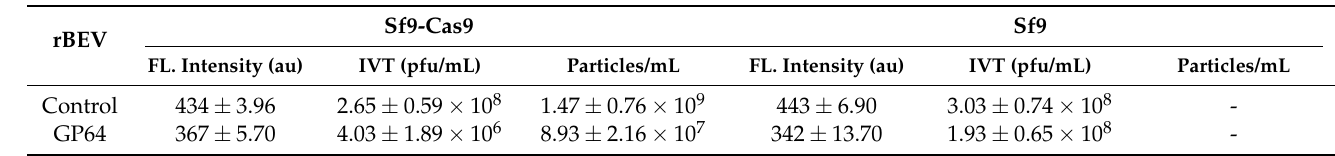
Table 3. Summary of fluorescence intensity and virus quantification data for rBEVs in Sf9 and Sf9-Cas9 cells at 48 hpi. A minimum n = 3 was used in all cases.